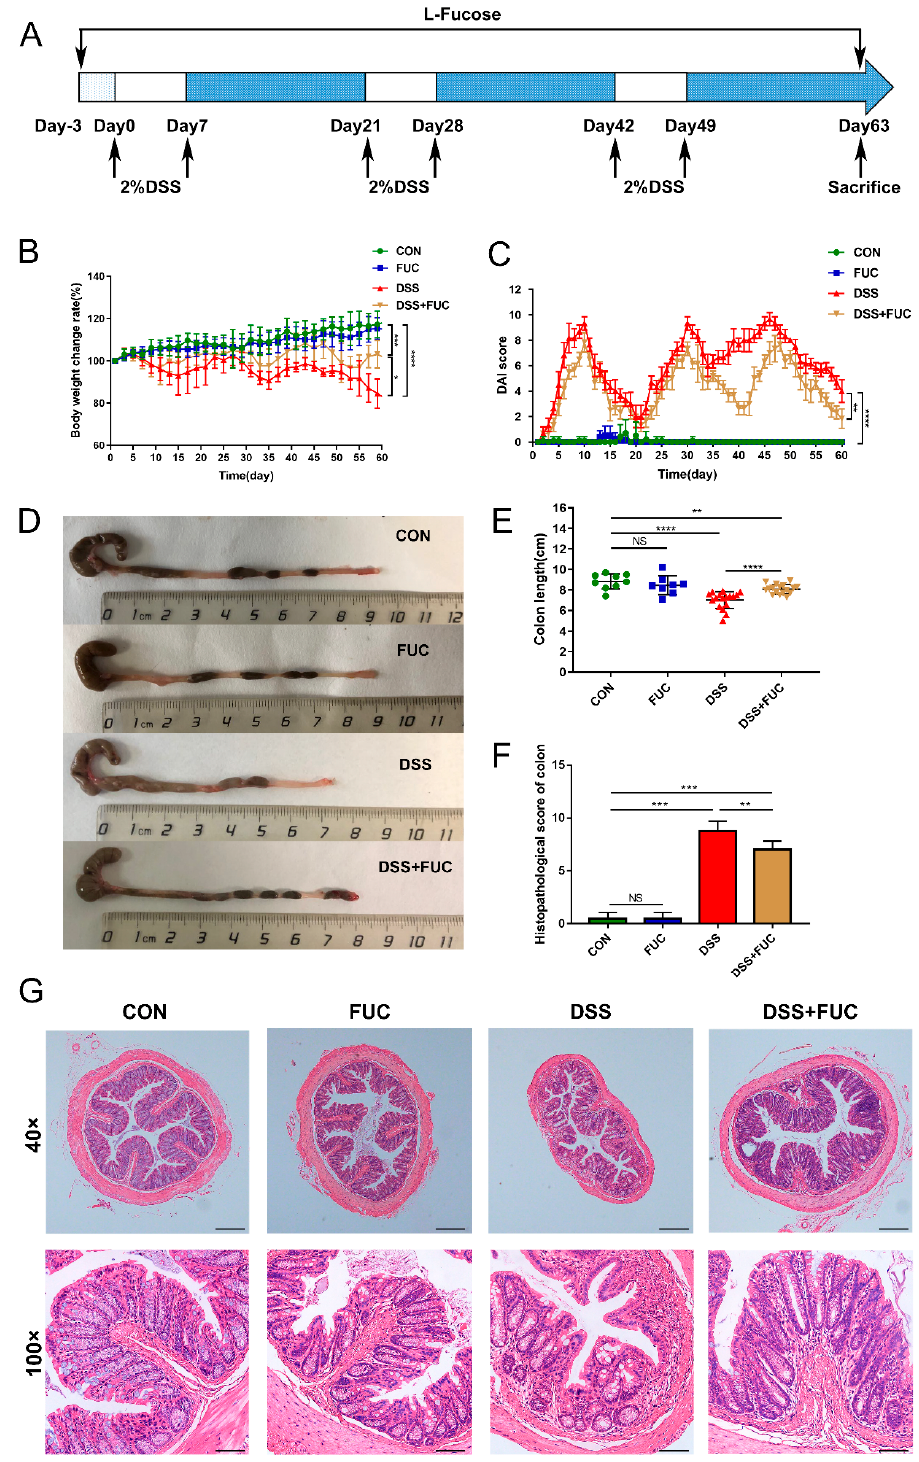
Figure 1. Amelioration of DSS-induced chronic colitis with L-fucose treatment. ( A ) Schematic diagram illustrating the experimental design. ( B ) Body weight percentage changes in each group. ( C ) Disease activity index (DAI) evaluations. ( D ) Comparisons of colon length in each group. ( E ) Quantitative analysis of colon length. ( F ) Histopathological scores of colons from each group of mice. ( G ) Representative images of H&E staining of colon sections. Magnification, 40 × (above), 100 × (below). Data are presented as the mean ± SD. * p < 0.05, ** p < 0.01, *** p < 0.001, **** p < 0.0001; NS, no